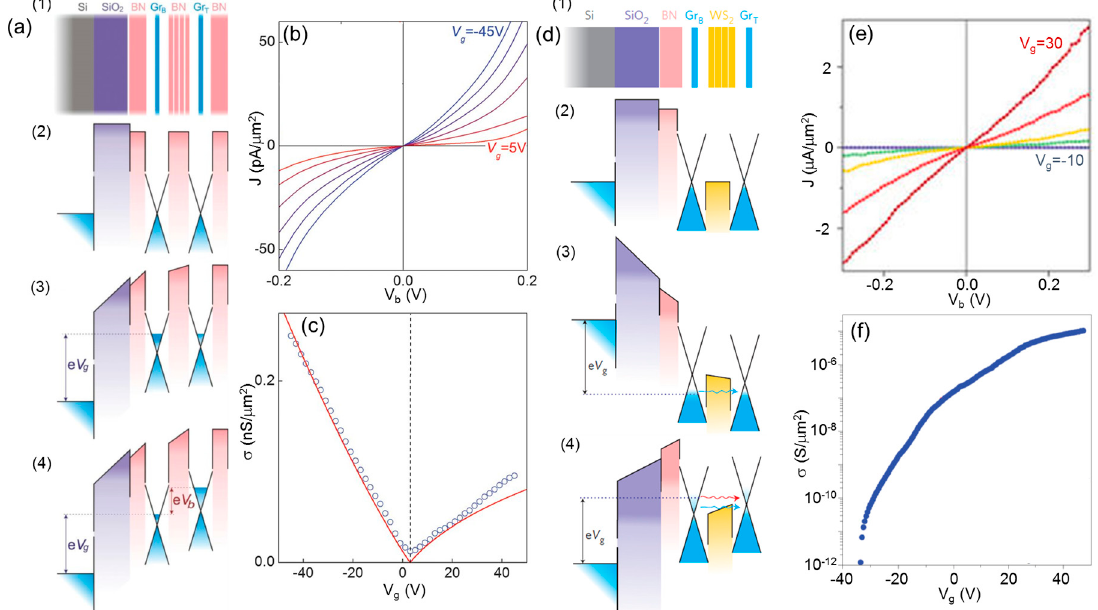
Figure 4. ( a ) Schematic illustration of a Gr/h-BN/Gr field effect tunneling transistor: (1) layer stacking;